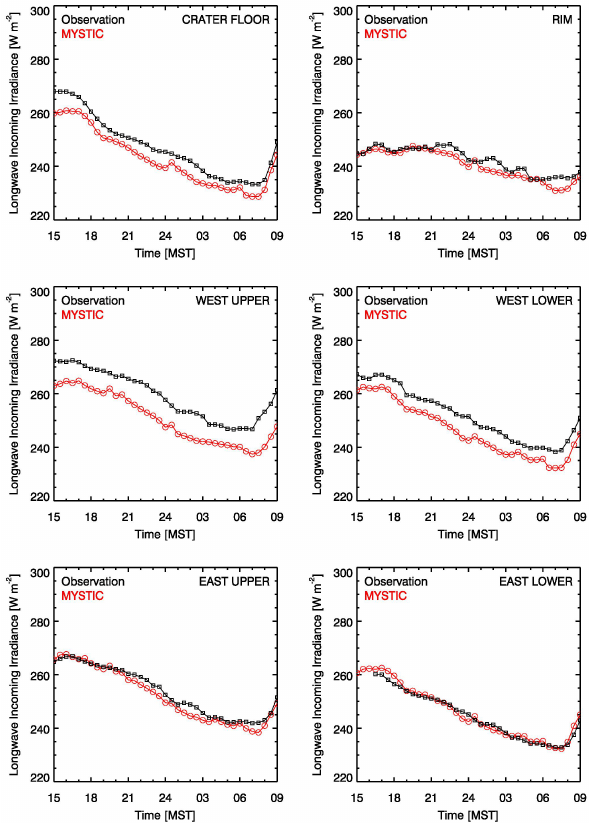
Fig. 10. Observed (black) and modeled (red) slope-parallel long- wave outgoing radiation at the six crater sites for the night of 22– 23 October